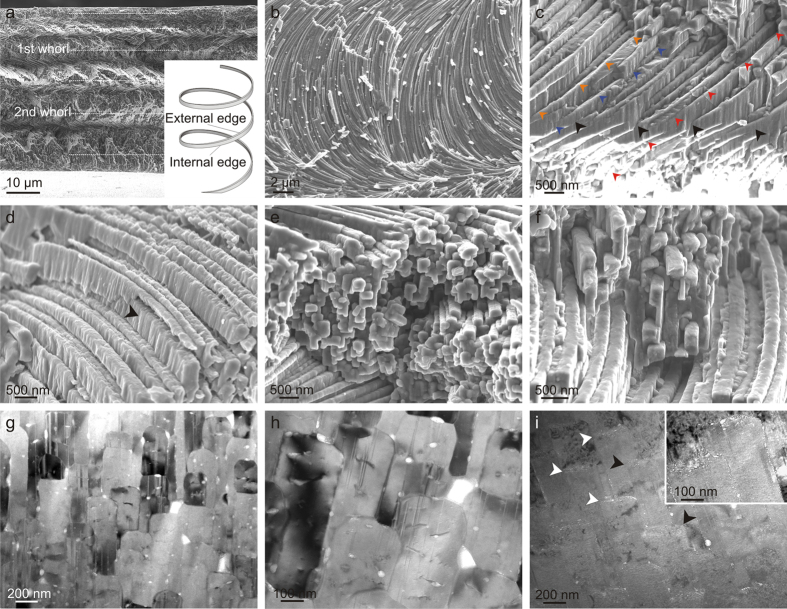
Fracture (SEM) and section (TEM) views of the AHFM of the Cavolinioidea.(a) Radial section of the shell of Cuvierina columnella. Horizontal broken lines are spaced at about half a turn. In this specimen, the helices complete some three turns. Note how the spacing between half turns (and, thus, the lead angle) increases towards the shell interior. The inset is a sketch of the ideal morphology of one such helical fibres. (b) Top view of a fracture through the shell of Cuvierina columnella, approximately parallel to the shell surface. The observed changes in orientation of fibres are caused by the unevenness of the fracture surface. (c) Fracture perpendicular to the surface of the shell of Cuvierina columnella, showing the interpenetration between fibres (black arrows). Colour arrows show the paths of three individual fibres (in different colours). (d) Etched fracture through the shell of Cavolinia longirostris. Etching permits a view of the complete process of crossing between two fibres; the lower fibre (arrow) crosses the upper fibre completely from right to left. (e,f) Transversely fractured fibres of Clio pyramidata (e) and Cuvierina urceolaris (f), showing the complex outlines caused by interlocking. (g) Transversal section of the fibres of Cuvierina columnella, exposing their interlocking cross-sections. The vertical thin lines within the fibres are twinning planes. (h) Detail of an area similar to (g). (i) Transversal section of the fibres of Cuvierina columnella. Fibres consistently show an external band (~150–200 nm thick) with an unusual density of white spots. The inset is a close-up of two such fibres. Arrows point to some examples. The external shell surface is to the top in (a) and (c) to (i).